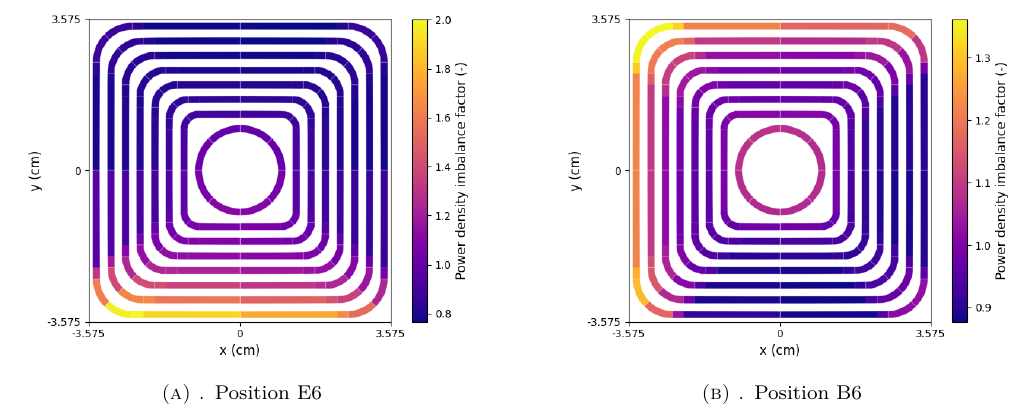
Figure 3. Reference power density imbalance factors k ( i )